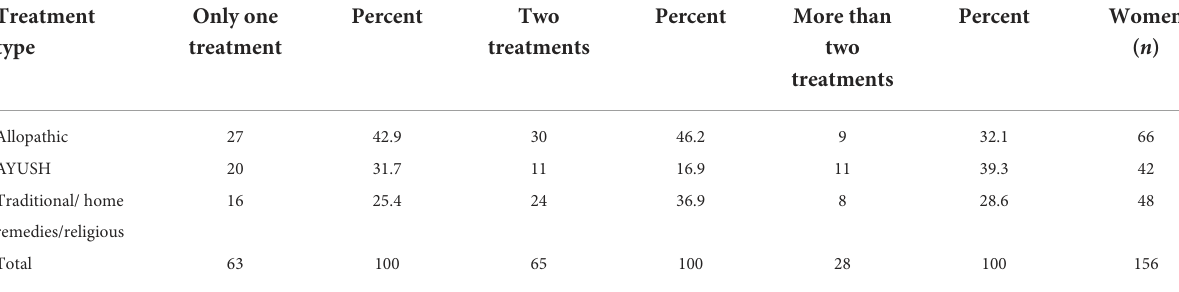
TABLE 3 Percentage of women received different types of treatments in